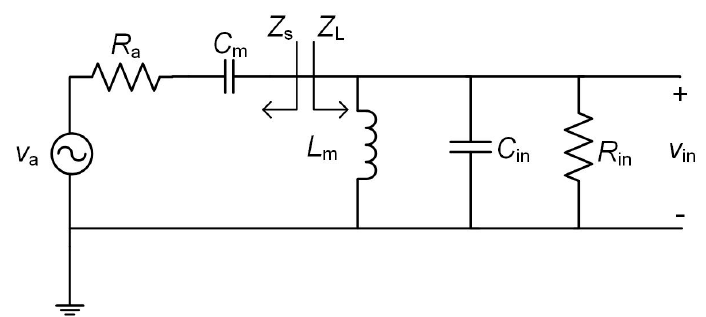
Figure 3. Equivalent circuit of the rectenna .